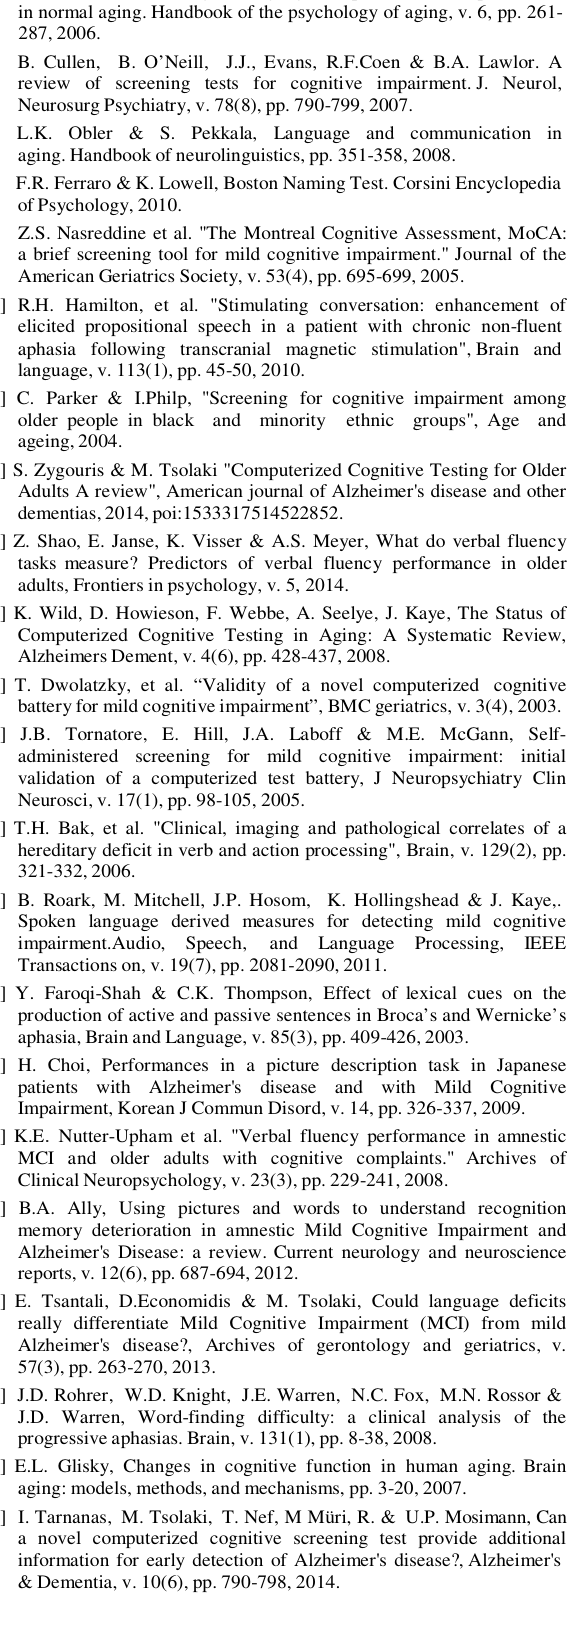
T ABLE 1. MCI SCREENING TEST